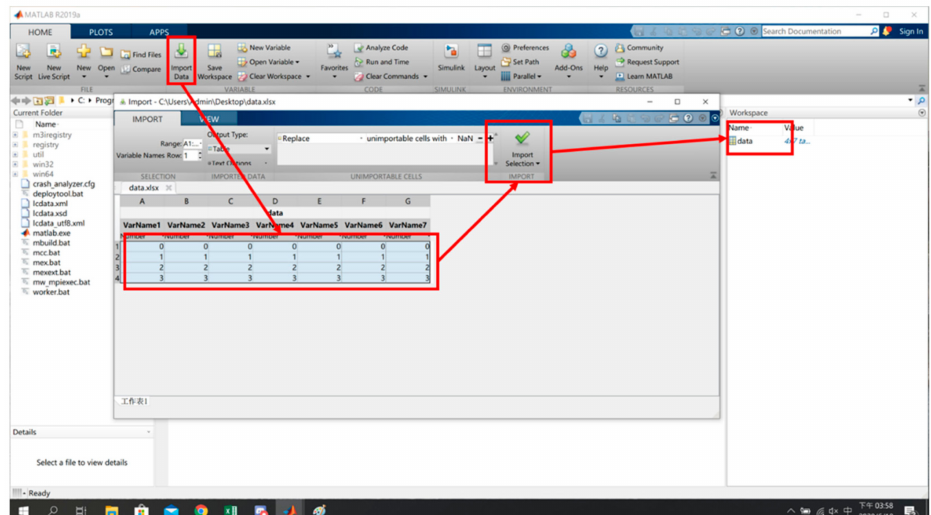
Figure 8. Input of Reference Point Data into MATLAB